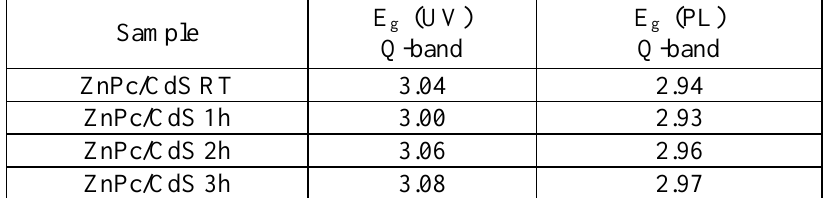
Fig.3: PL spectrum of ZnPc/CdS blended films. Table 2: Comparison between the values of E for prepared and heat treated ZnPc/CdS g blended films obtained from UV data and PL